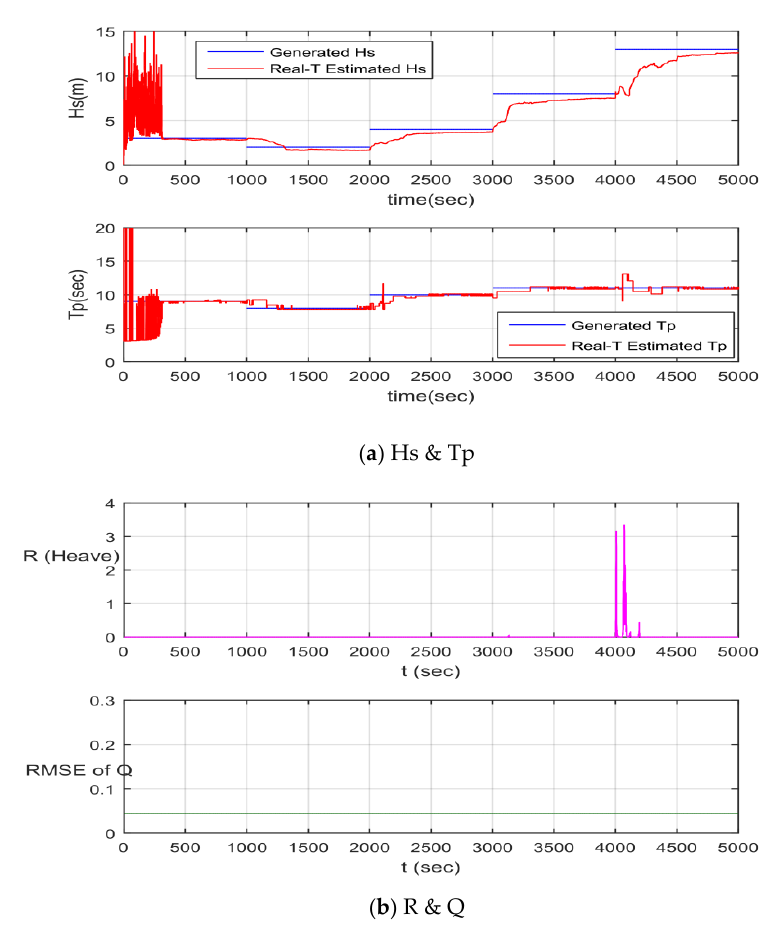
Figure 34. ( a ) Evolution of parameters, ( b ) R (adaptive) and Q (fixed) during sea state change.